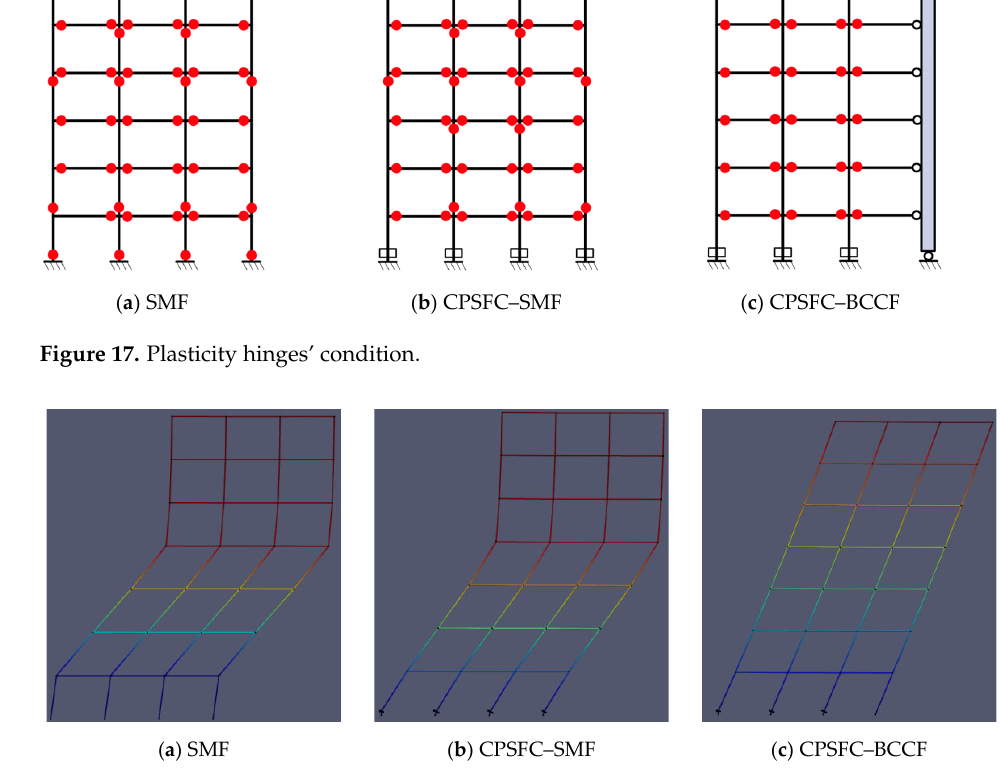
Figure 17. Plasticity hinges ’ condition. Figure 18. Collapse mode. Figure 18. Collapse